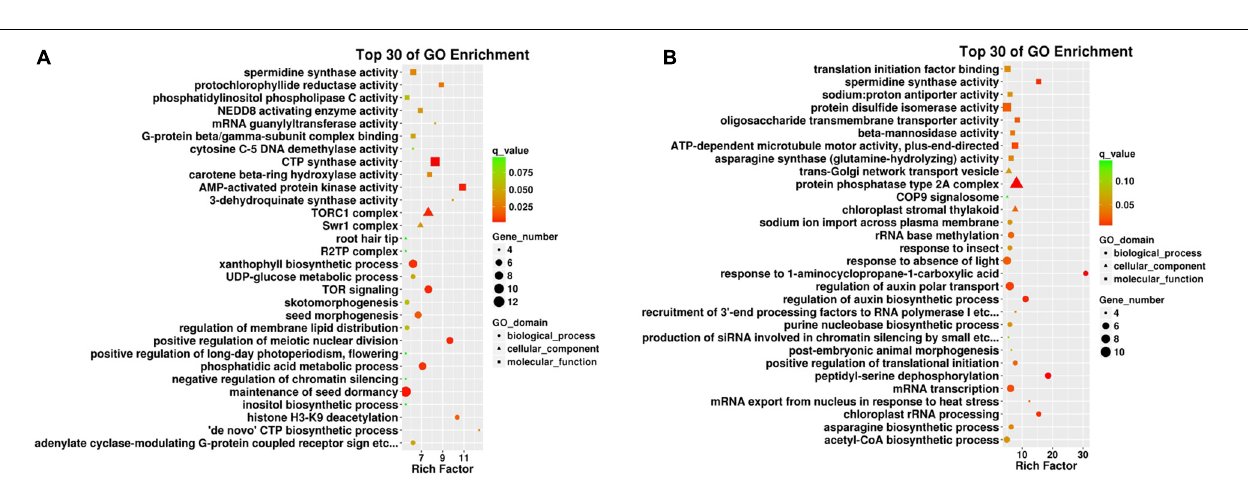
FIGURE 3 | Gene number distribution in different GO classification terms. A group of significant GO terms were identified through GO enrichment analyses. Distribution of gene numbers in different GO classification terms in different tissues: (A) roots and (B) leaves. Different colors indicate different GO domains.